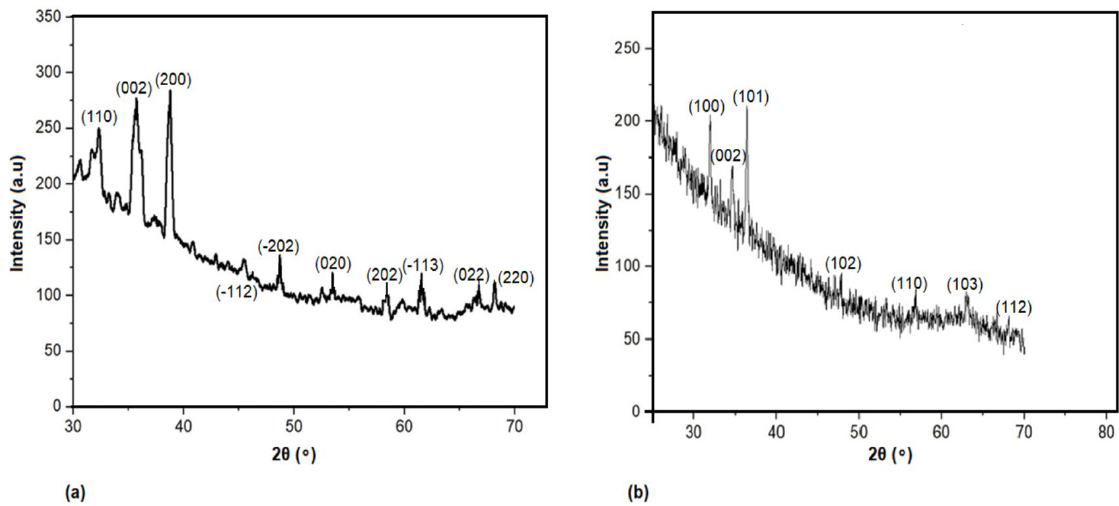
Figure 1. X-ray diffraction (XRD) pattern of ( a ) bacteriogenic CuO nanoparticles and ( b ) bacteriogenic ZnO nanoparticles synthesized by Stenotrophomonas